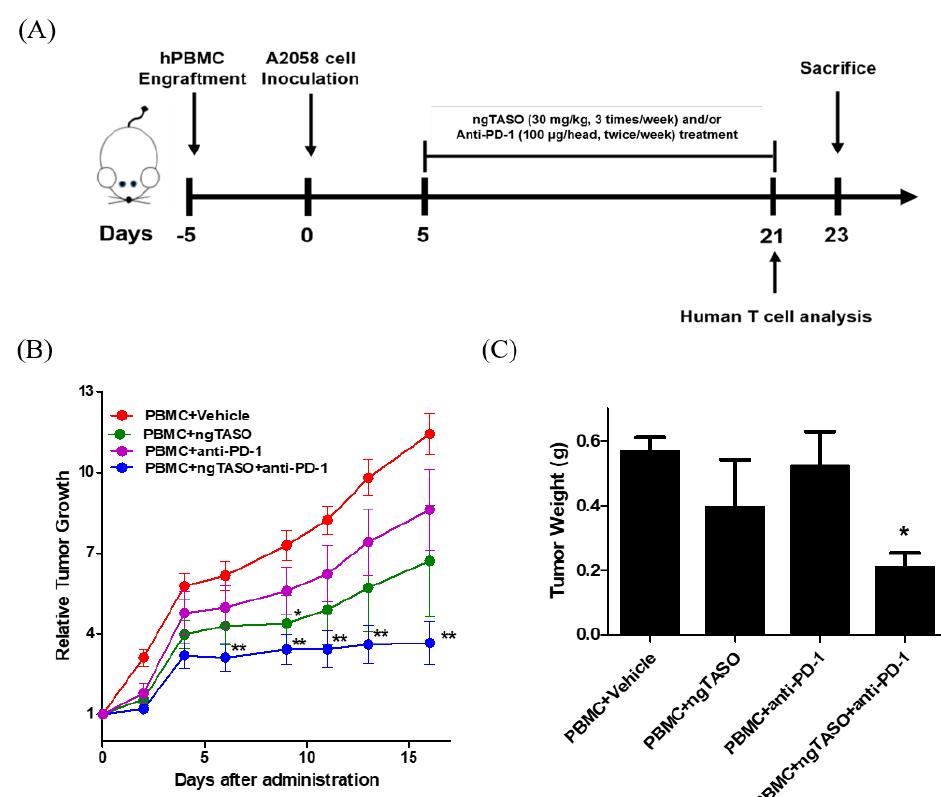
Figure 2. Effects of ngTASO and anti-PD-1 co-treatment on tumor growth. Melanoma-bearing human immune system mouse model was generated by transplanting human PBMC followed by inoculation of A2058 cells into NSG-B2m mice. ( A ) Experimental scheme for the establishment of melanoma-bearing hu-PBL NSG-B2m mice and treatment of ngTASO and/or anti-PD-1 antibody. ( B ) Relative tumor growth was calculated using the formula ((tumor volume on the day of measurement)/(tumor volume on the day of first administration)). ( C ) Tumor weights were measured at study termination (23 days after tumor inoculation). The results are expressed as mean ± S.E.M. obtained from six mice per group. * p < 0.05 and ** p < 0.01 vs. PBMC+Vehicle group (Dunnet’s test).